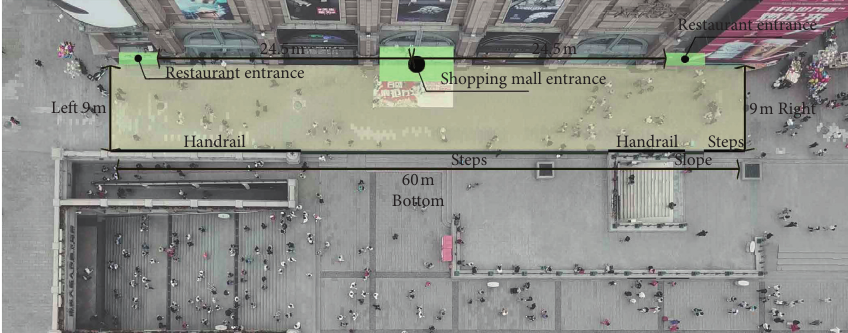
Figure 3: Snapshot of the UAV video footage, where the yellow area is the case study